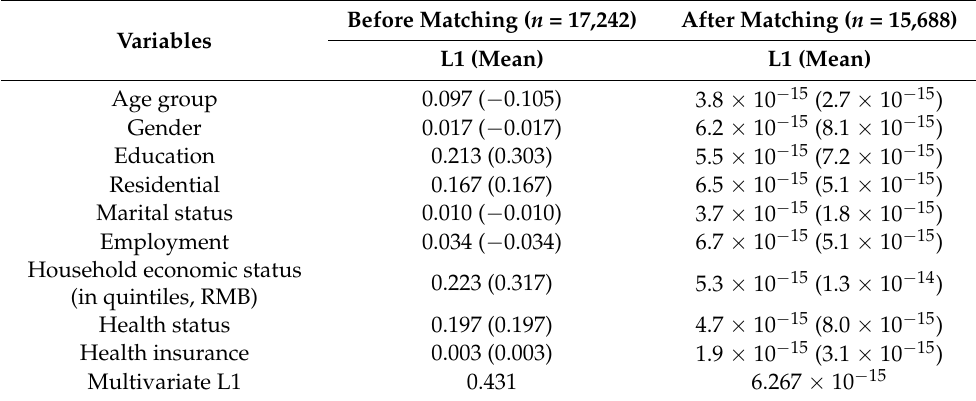
Table 3. The L 1 statistic before and after